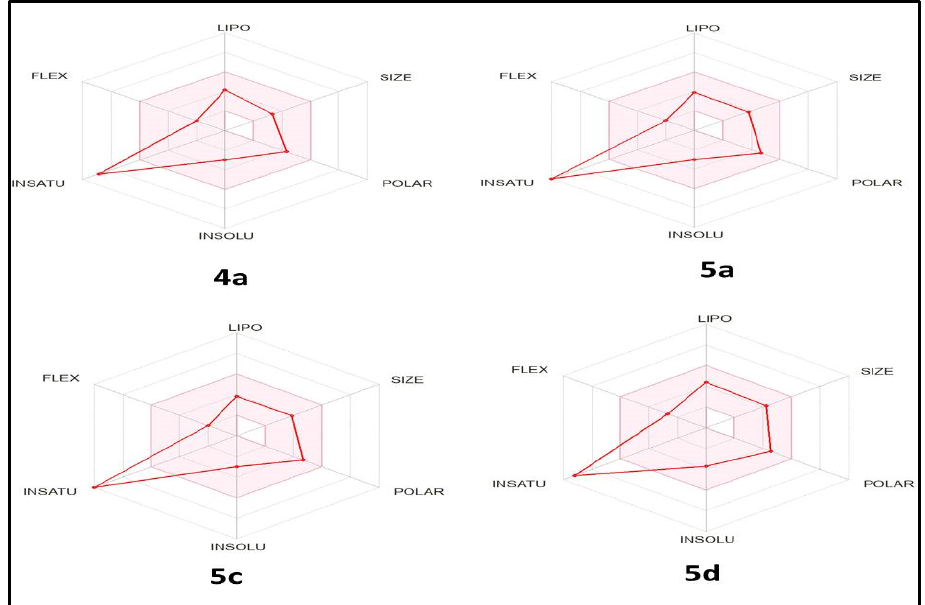
Figure 6. The bioavailability radar chart illustrating the oral bioavailability parameters of compounds 4a , 5a , 5c , and 5d . Table 5. Predicted physicochemical properties of the most active quinazolin-4(3 H )one derivatives 4a , 5a , 5c , and 5d .